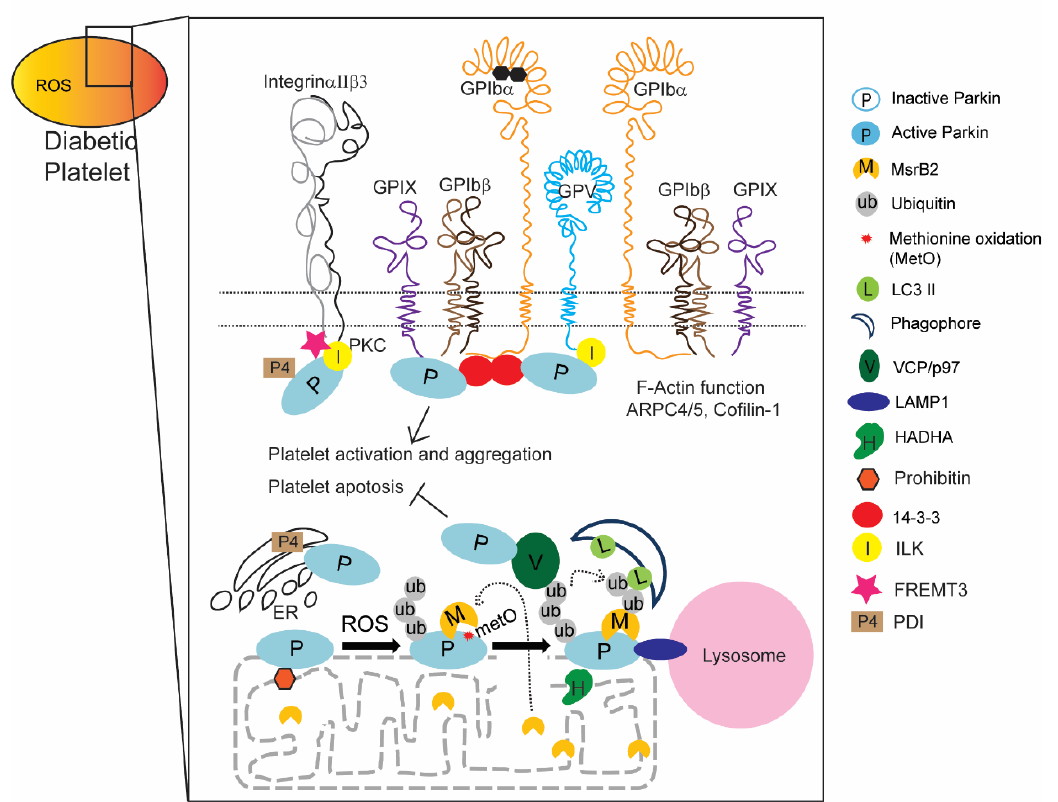
Figure 6. Summary of Parkin functions in DM platelets.